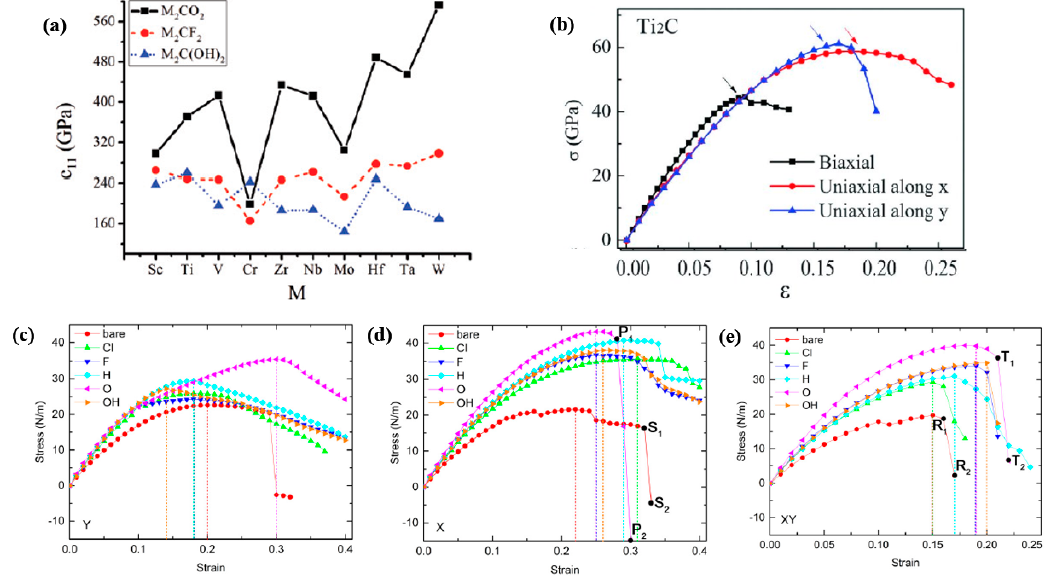
Figure 1. ( a ) The elastic constants of c11 for M 2 CT 2 MXenes. Reproduced with permission from [ 27 ] .